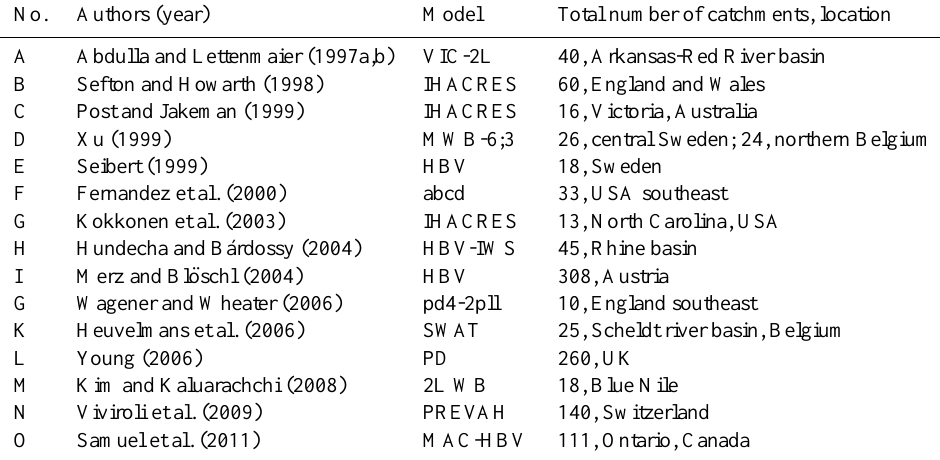
Table 2. Summary of authors, year, the model, and number and location of catchments used in 15 regional studies. They are randomly selected and listed in a chronological order as they appear in